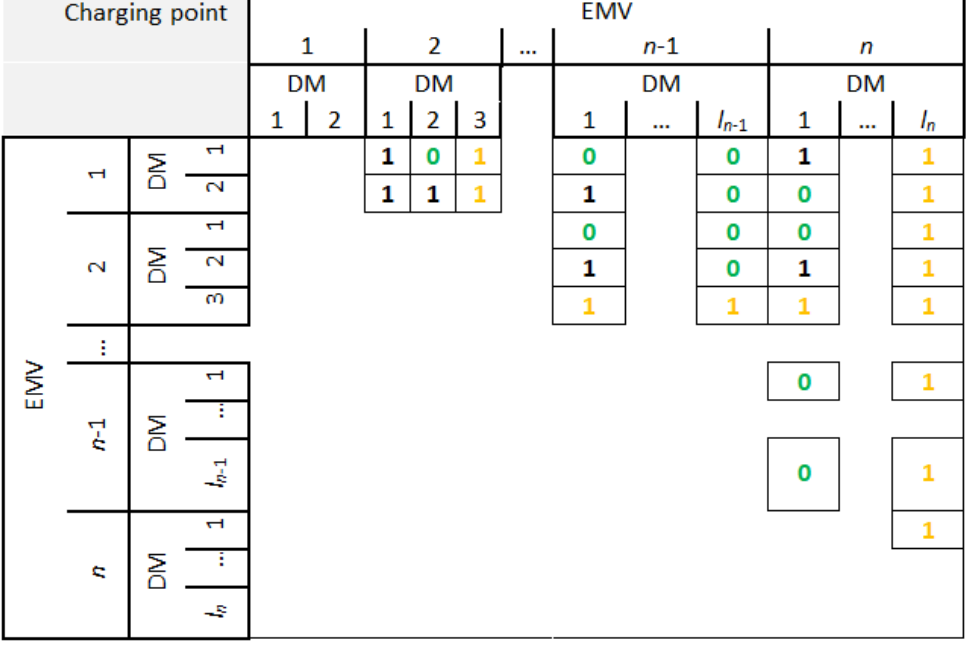
Figure 4. Excerpt of an exemplary 2D conflict matrix (single charging